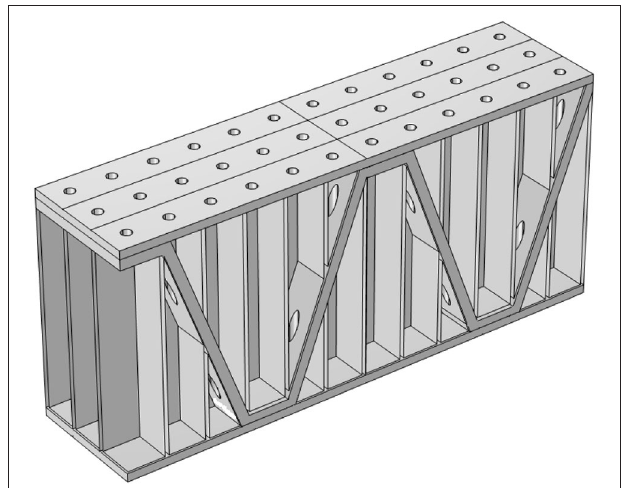
FIGURE 1 | The geometry of the underwater PHCH